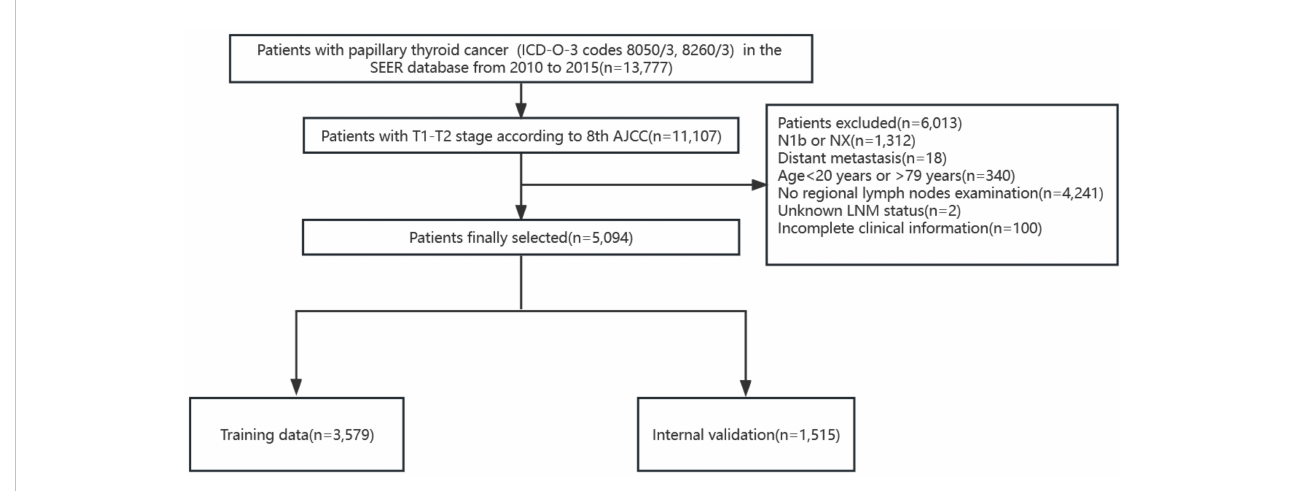
FIGURE 1 Flowchart of patient selection in SEER database. AJCC, American Joint Committee on